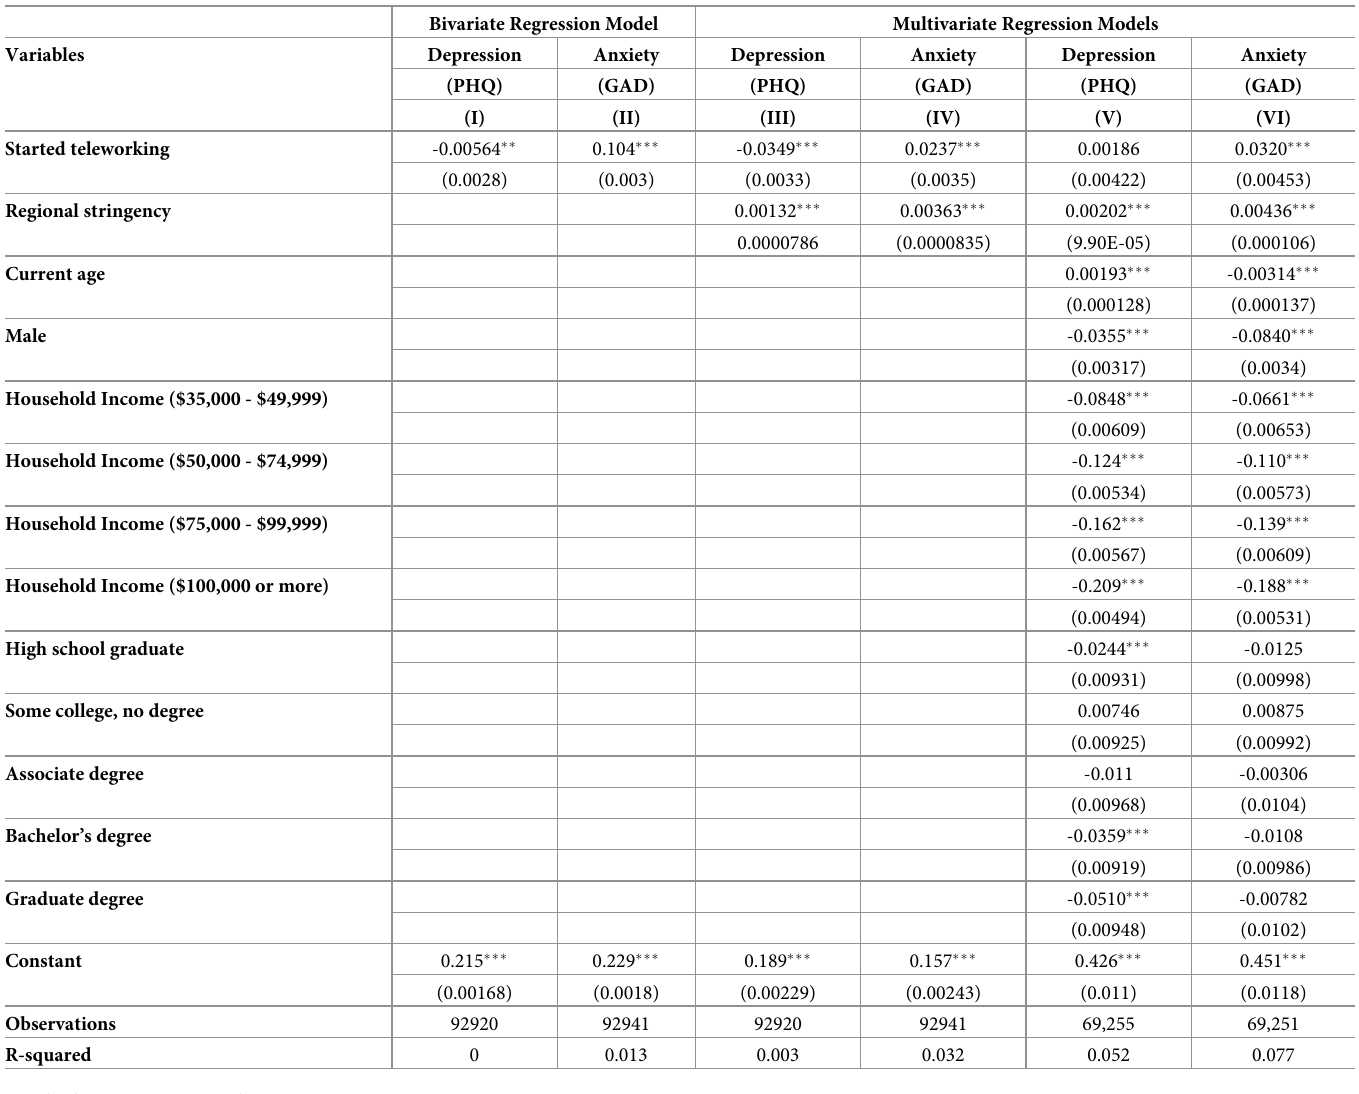
Table 4. Linear Probability Model (LPM)